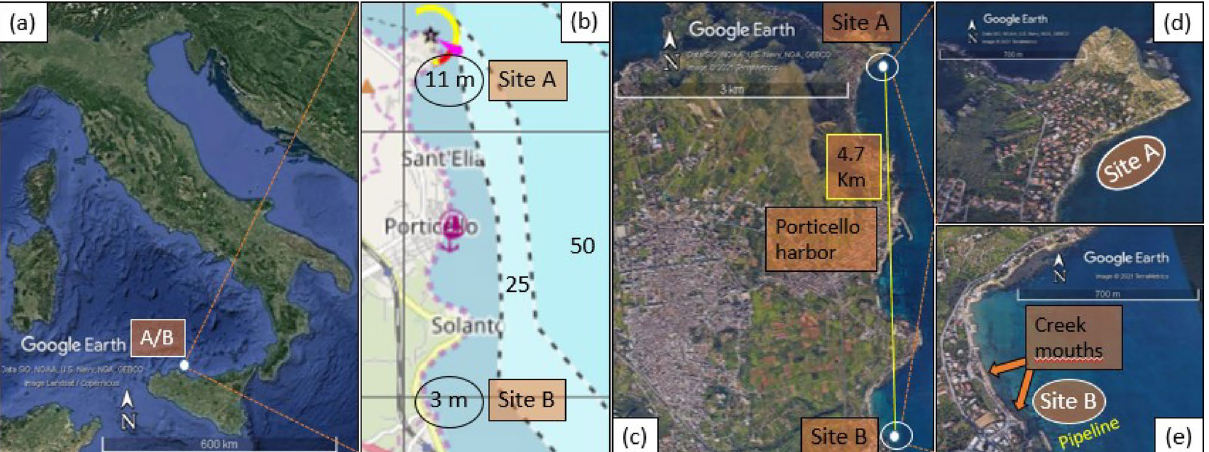
Figure 1. Map of the sampling site. ( a ) Geographic area, ( b ) bathymetric chart and ( c ) relative distance between sample sites; ( d , e ) close ups of sampling sites. (Images obtained by courtesy of Google Earth Pro and map.